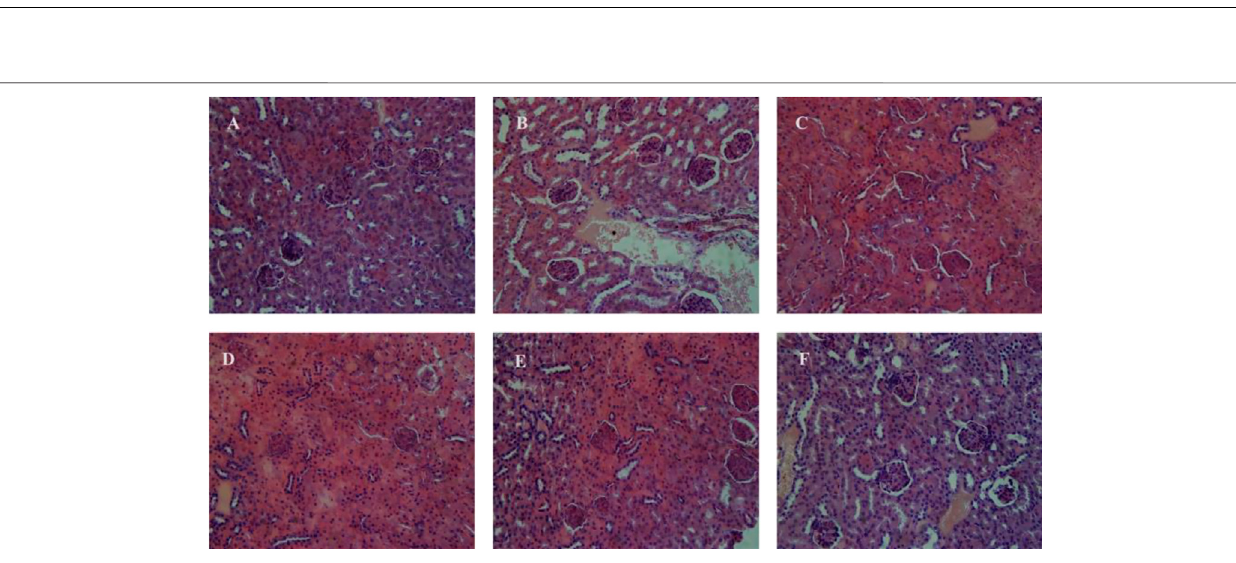
FIGURE 9 | Micrographs express the renal (kidney) tissues of the mice hematoxylin – eosin (H&E staining; magni fi cations × 400). (A) C +ve, (B) C − ve, (C) L. acidophilus KLDS1.1003only, (D) MRS-basedencapsulated L.acidophilus KLDS1.1003only, (E) L.acidophilus KLDS1.1003pluslead, (F) MRS-basedencapsulated L. acidophilus KLDS 1.1003 plus